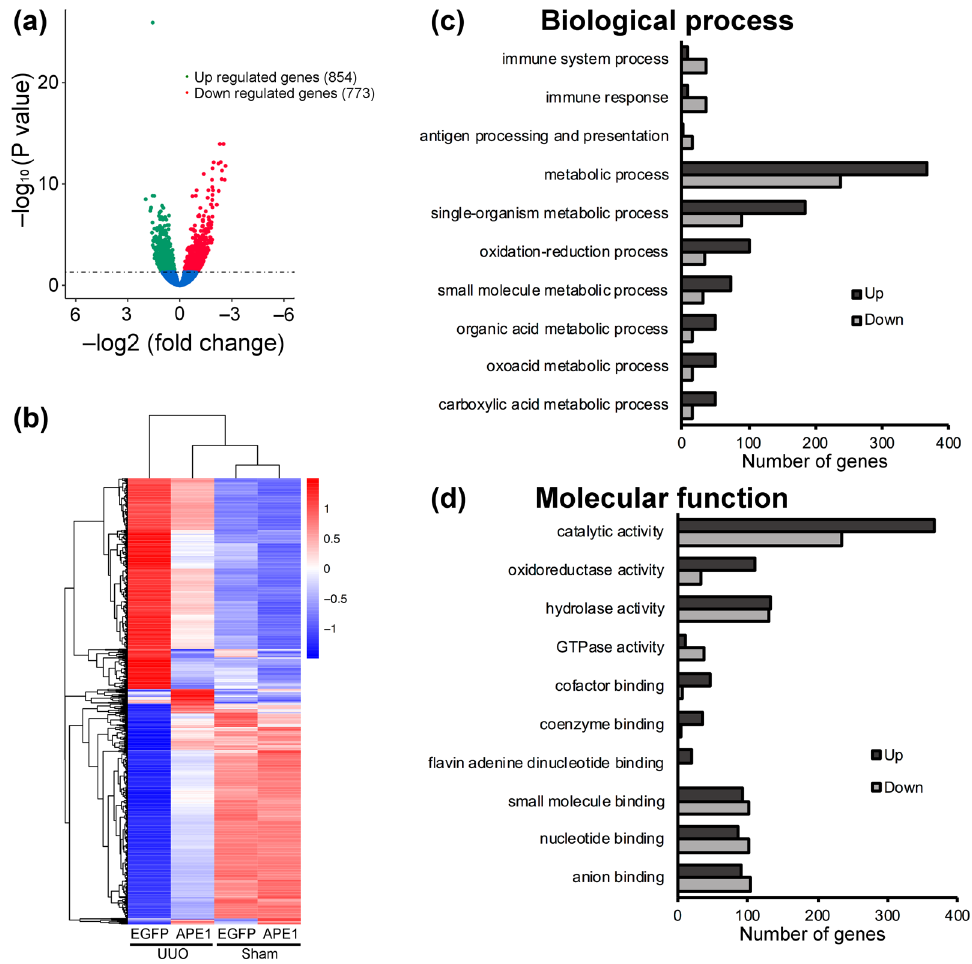
Figure 4. Differentially-expressed gene (DEG) results and the 10 most enriched Gene Ontology (GO) terms comparing pCAG-APE1- and pCAG-EGFP-injected unilateral obstructed ureter (UUO) kidneys. ( a ) Volcanic plot of DEGs. Red dots represent significantly up-regulated DEGs (n = 854) and green dots represent significantly down-regulated genes (n = 773). ( b ) Hierarchical clustering heatmap of DEGs across four comparisons. Red represents highly-expressed genes and blue represents low gene expression. Color descending from red to blue indicates log 10 (FPKM + 1) from high to low expression. ( c,d ) The histogram shows the topological relationships among the 10 most enriched GO terms. Circles and boxes with different colors represent enriched GO terms based on biological process ( c ) and molecular function ( d )